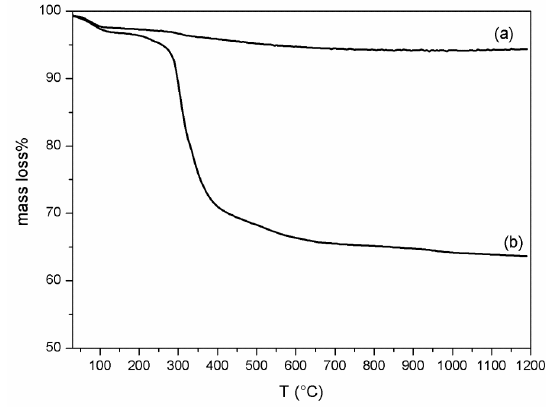
Figure 5. TGA of SBA-15 ( a ) and VC-IP@SBA-15 ( b ).